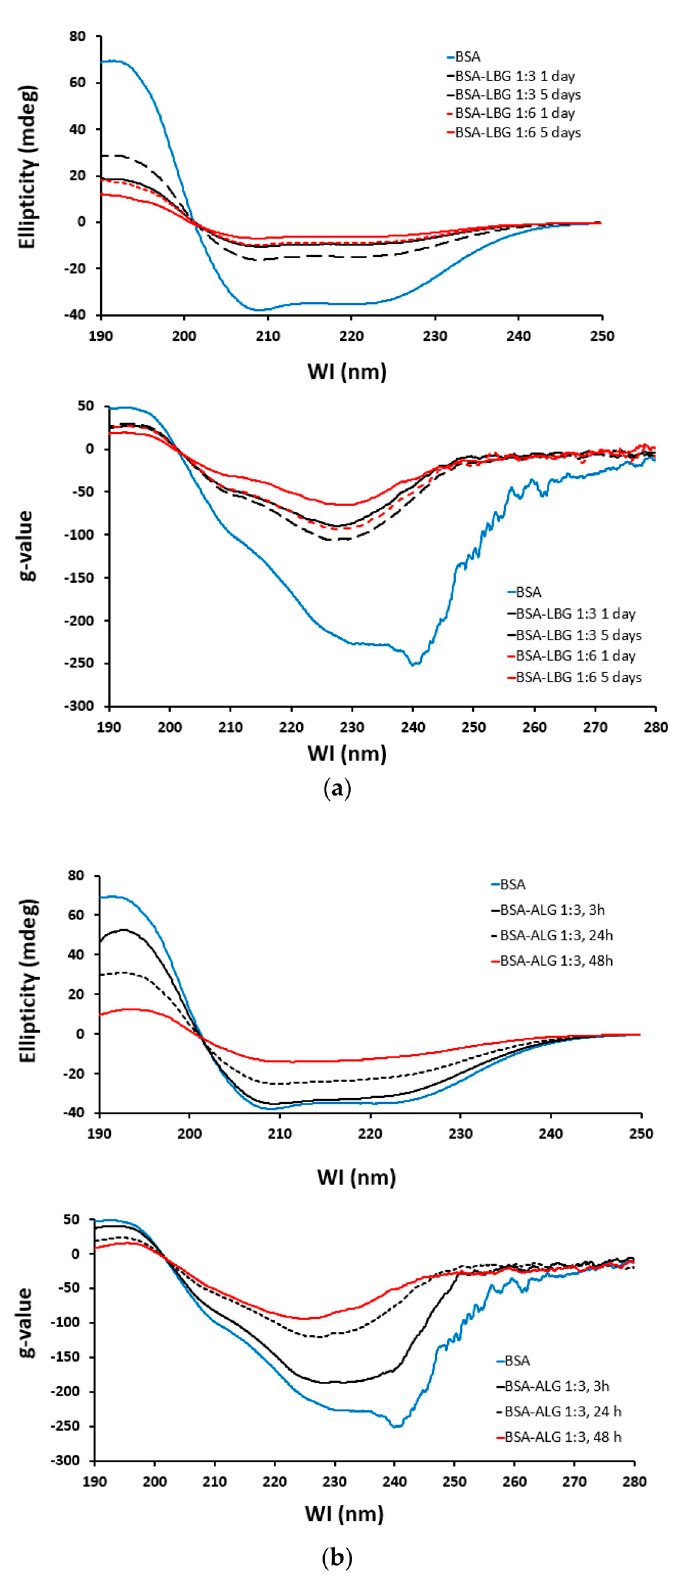
Figure 8. CD (upper) and G spectra (lower) of various BSA conjugates with increasing reaction time: ( a ) BSA (blue), BSA–LBG 1:3 conjugates (black dashed line, 1 day and black solid line, 5 days), and BSA–LBG 1:6 (red dashed line, 1 day and red solid line, 5 days); ( b ) BSA (blue), BSA–ALG 1:3 3 h (black solid line), 24 h (black dashed line), and 48 h (red solid